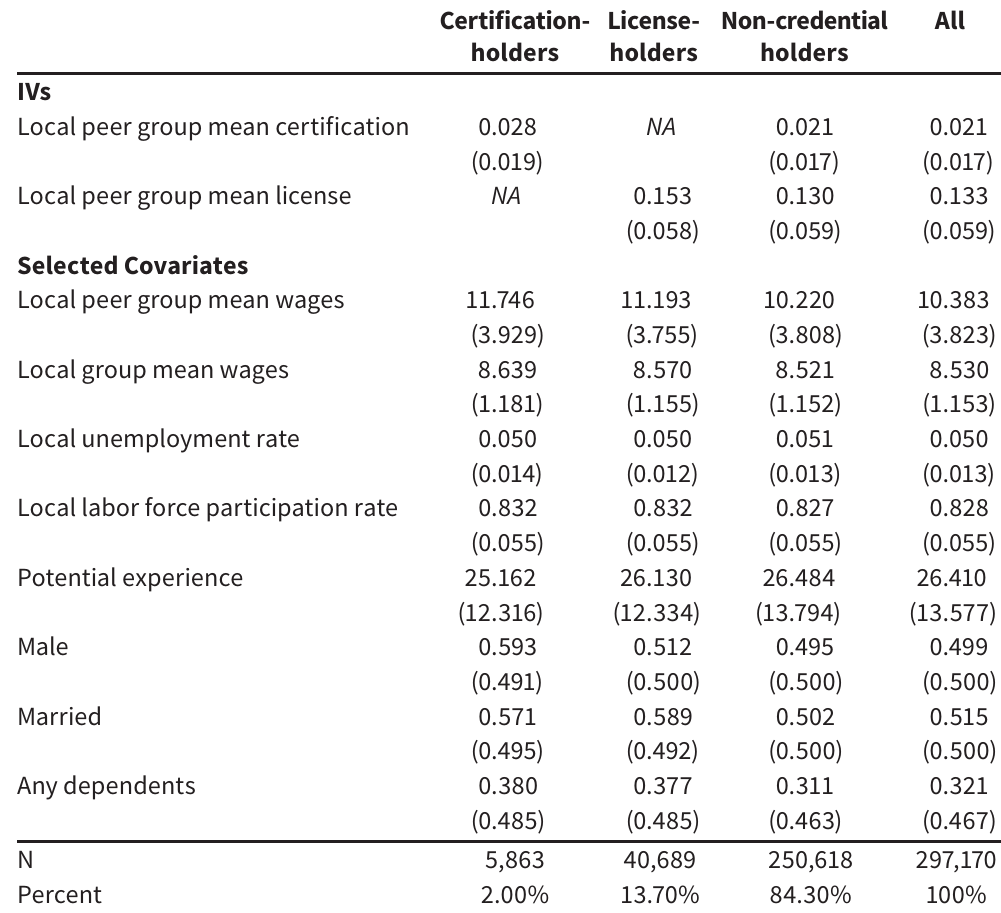
Table 1 Sample Characteristics, Sub-Baccalaureate